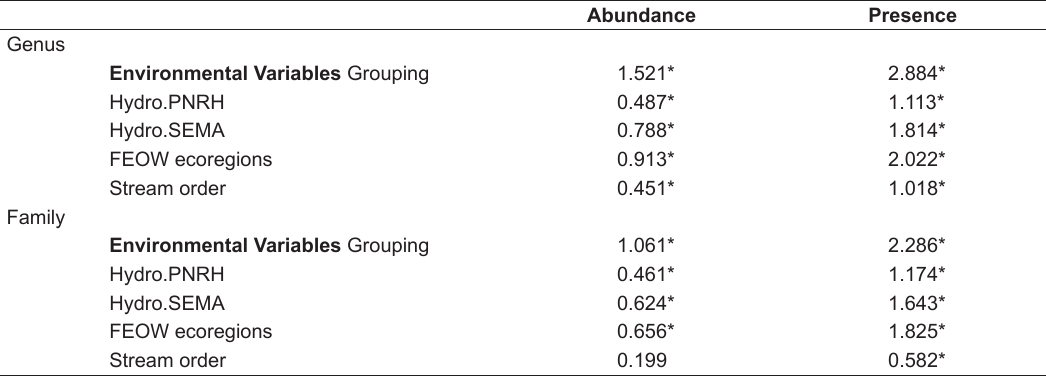
Table 4. Sum of Squares values for db-MANOVA results by community differences among stream classifications (n=37).